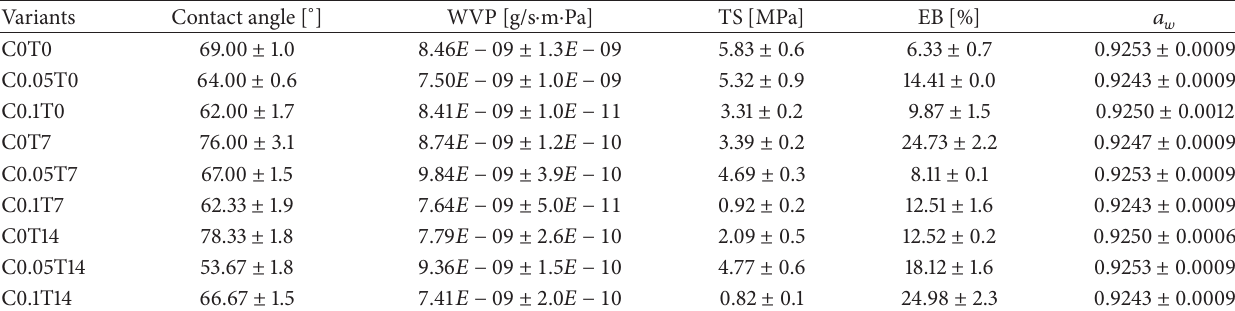
Table 2: Results of contact angle, WVP, and 𝑎 𝑤 and mechanical properties results of polysaccharides films.